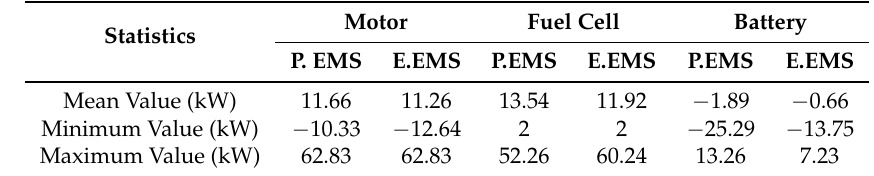
Table 6. Power statistics of fuel cell, battery, and